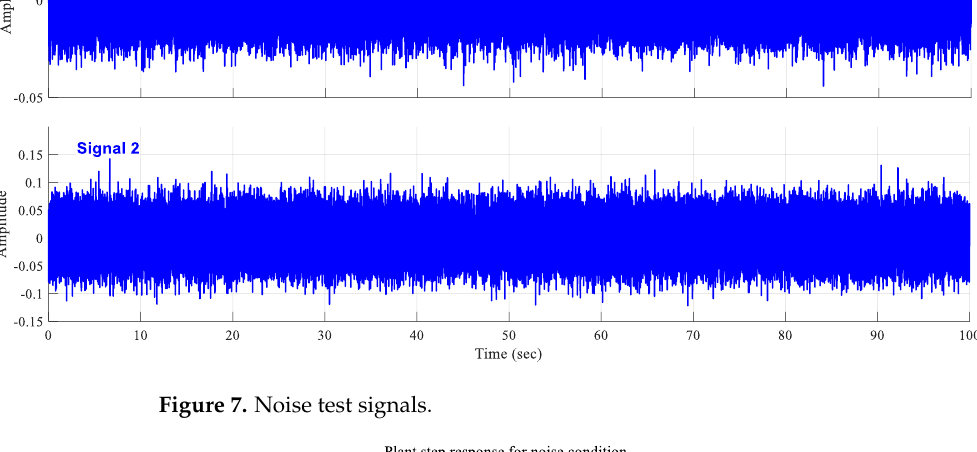
Figure 7. Noise test signals.